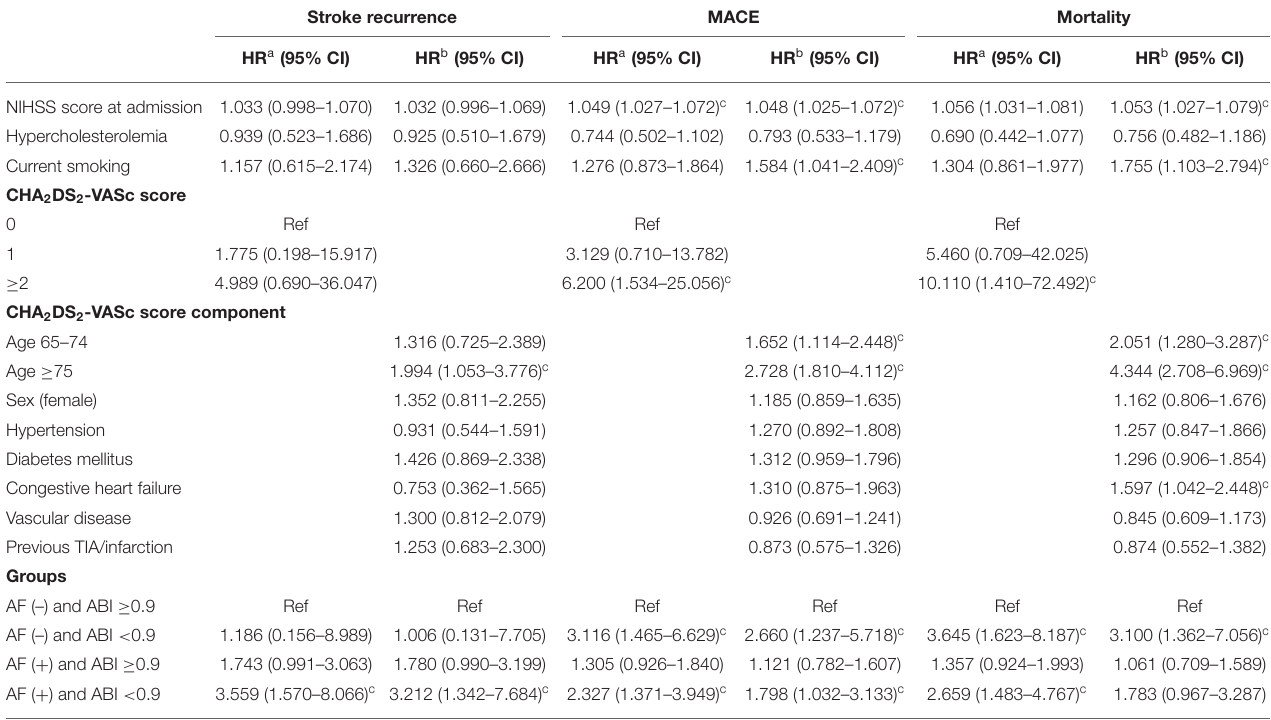
TABLE 2 | Multivariate Cox proportional hazards regression